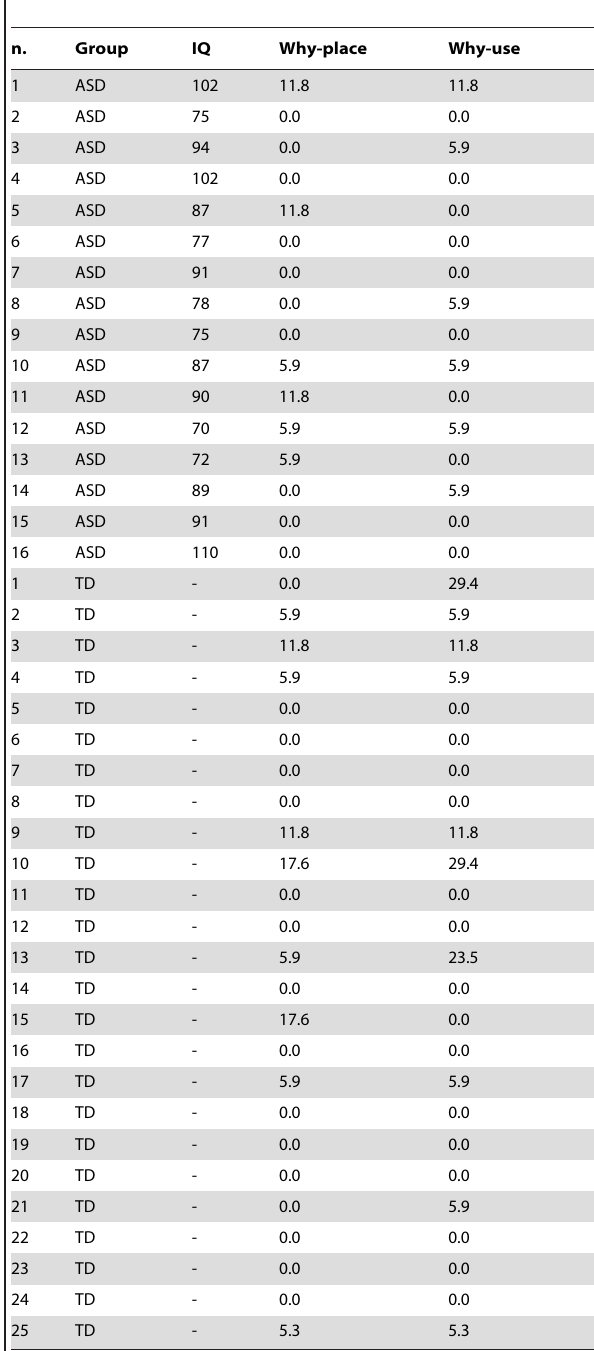
Table 4. Individual error rates expressed as percentages for all participants in the Experiment